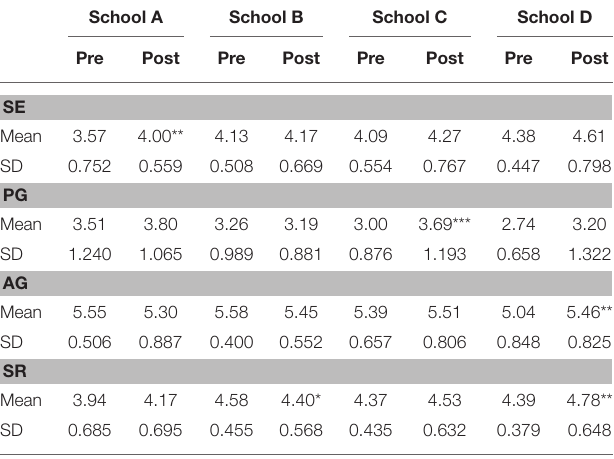
TABLE 11 | Results from the questionnaires on perceptions of clarity of goals and assessment criteria for Schools